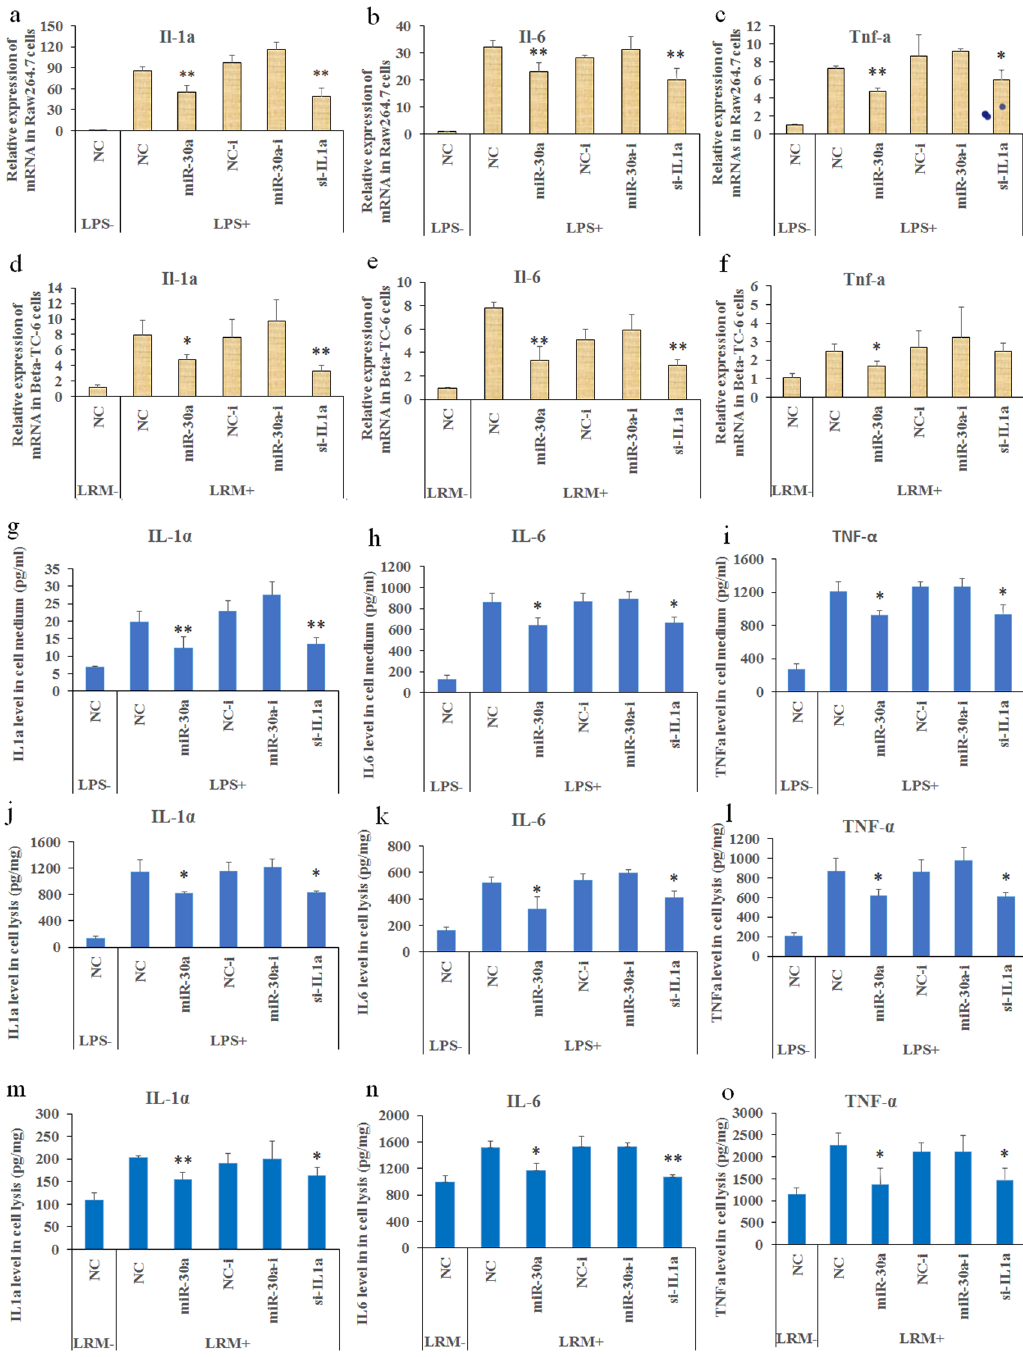
Figure 2. Effects of miR-30a mimics on the mRNA and protein expressions of inflammatory factors. ( a – f ) RT-PCR showing miR-30a mimics significantly inhibited the increased mRNA expressions of Il-1a, Il-6 and TNF-a in LPS-induced RAW264.7 and LRM-induced Beta-TC-6 cells. ( g – o ) ELISA showing that miR-30a mimics significantly inhibit the increased protein levels of IL-1 α , IL-6 and TNF- α in RAW264.7 cells after 24 h of LPS induction (samples from cell medium and lysis) as well as in Beta-TC-6 cells after 24 h of LRM induction (samples from cell lysis only). LPS + / − , incubation with or without LPS; LRM + / − , incubation with or without LRM; NC, negative controls of miRNA mimics; NC-i, negative controls of miRNA inhibitors or siRNA; miR-30a-i, miRNA-30a inhibitor; and si-IL1a, silencing mRNA fragment of Il-1a. Data are expressed as the Mean ± SD (n = 3); * P < 0.05 and ** P < 0.01 vs. NC or NC-i (LPS/LRM + ),